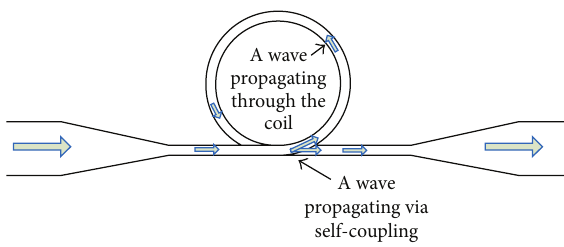
Figure 1: Schematic diagram of the microfiber loop resonator.